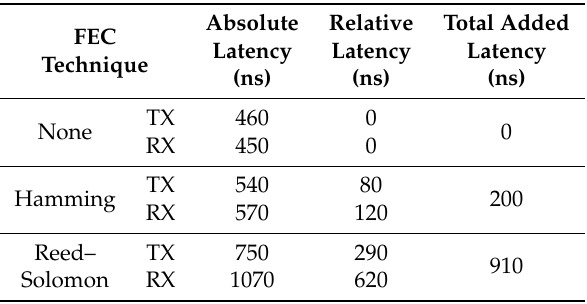
Table 5. Latency test results.